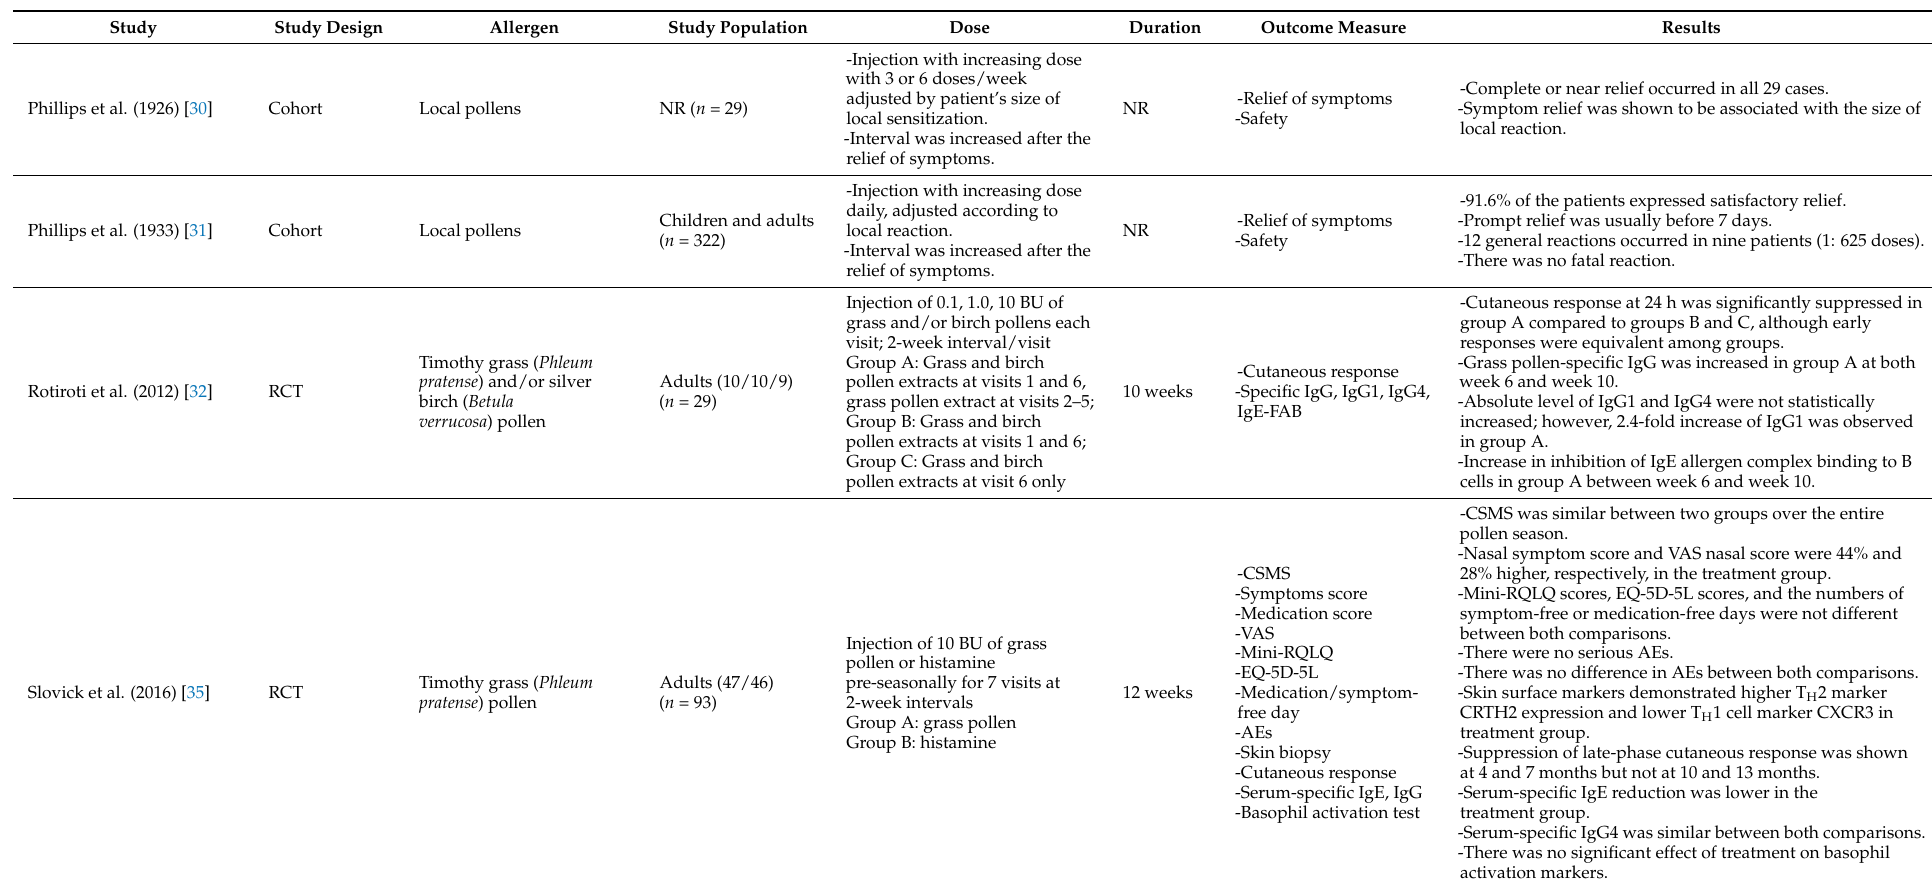
Table 1. Clinical studies of